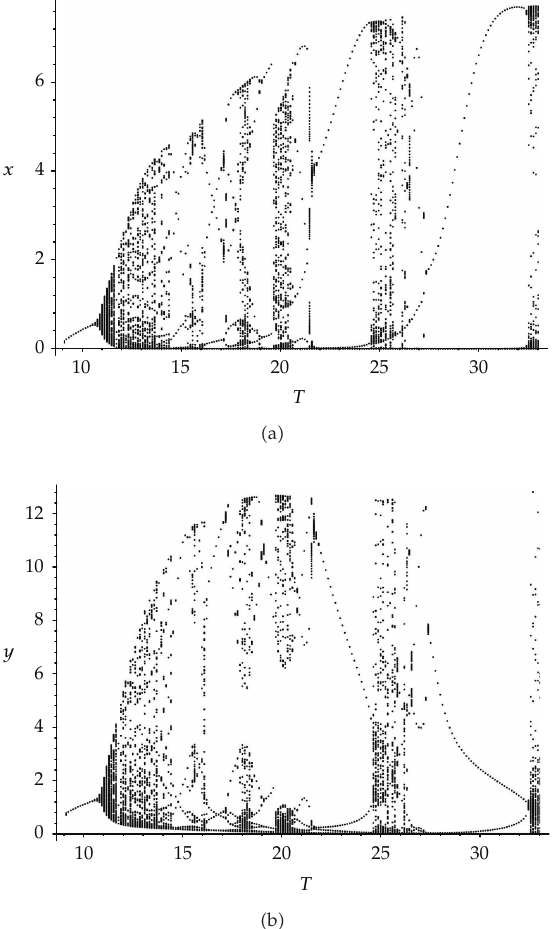
Figure 3: Bifurcation diagrams for system (cid:2) 1.1 (cid:3) showing the e ff ect of T with p (cid:7) 4; we keep other parameters the same. (cid:2) a (cid:3) x versus T , (cid:2) b (cid:3) y versus T .